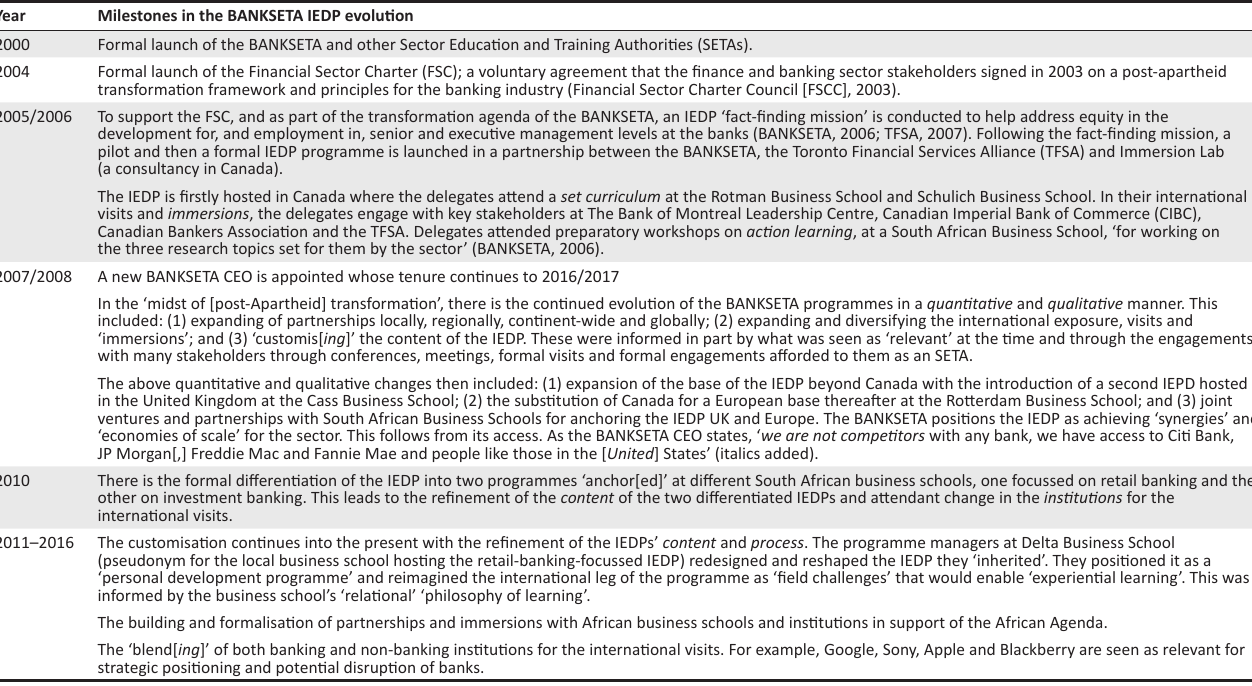
TABLE 2: Evolving Banking Sector Education and Training Authority International Executive Development